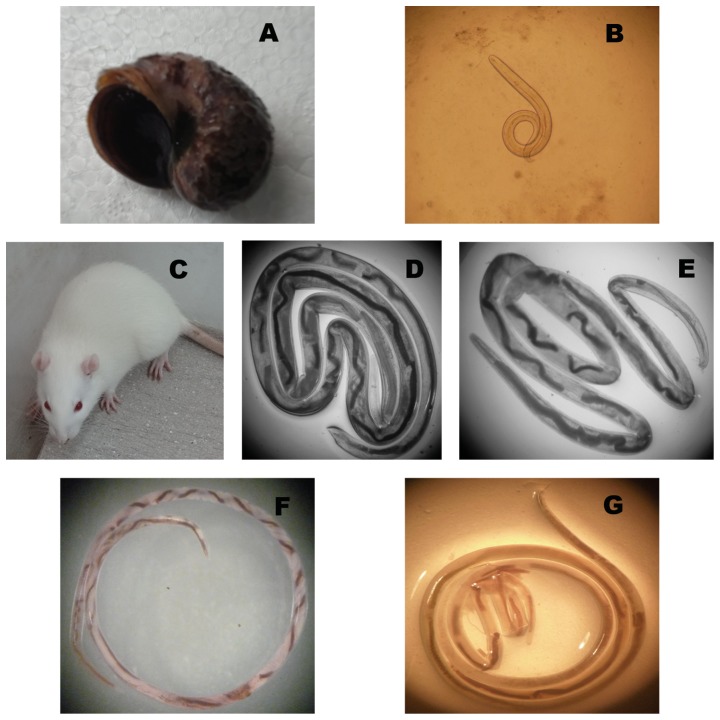
Different developmental stages of Angiostron gylus cantonensis and their hosts.
A, Pomacea canaliculata, as the intermediate host. B, the third stage larvae (L3) (10×10). C, Sprague-Dawley (SD) rats, as the difinitive host. D, female of the fifth stage larvae (FL5)(10×4). E, male of the fifth stage larvae (ML5)(10×4). F, female of the adult (FA)(10×). G, male of the adult (MA)(10×).